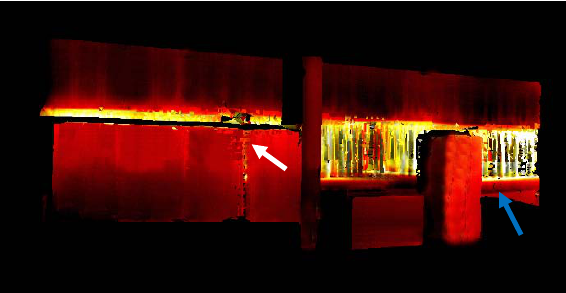
Figure 12. Textured 3D model obtained after the calculation of the rotation matrix and the translation vector for the 10 thermographic images needed to cover the wall. Temperatures rise from 24.5ºC (dark red) to 31.5ºC